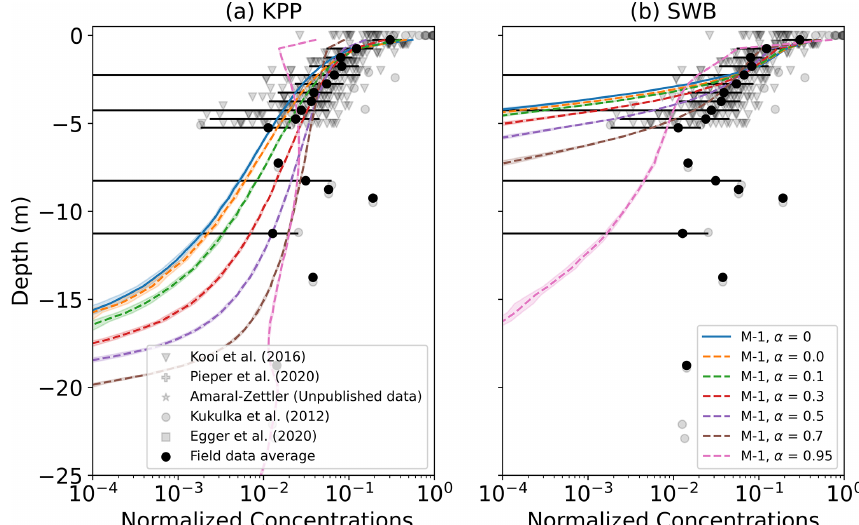
Figure 6. Vertical concentrations of buoyant particles for (a) KPP and (b) SWB diffusion using M-0 and M-1 models with varying values for α . The grey markers indicate field measurements, with darker shades indicating more measurements, while the binned field measurement average and standard deviation are shown by the black markers. Shading around the profiles indicates the profile’s standard deviation at each depth level. The KPP profiles are for θ = 1 . 0 and z 0 according to Eq. (12). All profiles are for u 10 = 6 . 65ms − 1 and medium-buoyancy particles ( w rise = 0 . 003ms − 1 ).